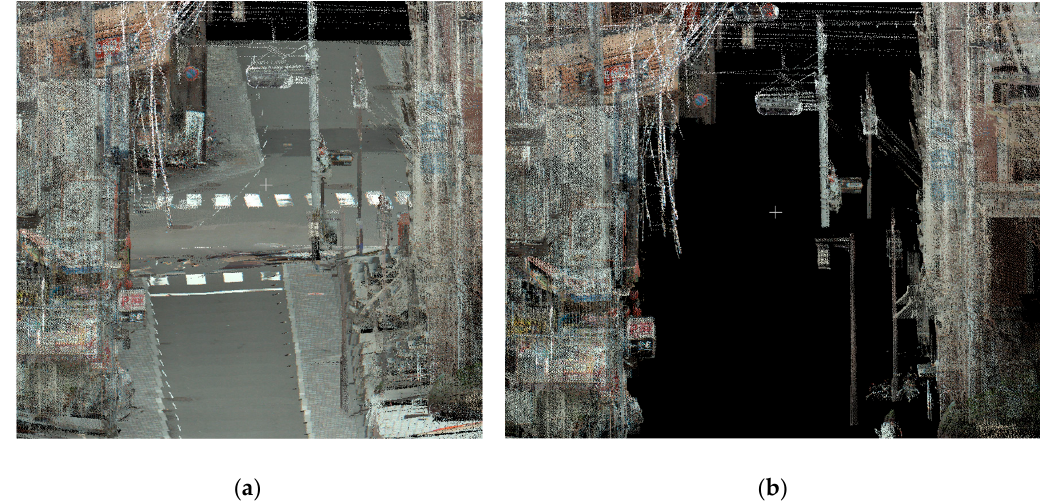
Figure 9. Laser-scanned point cloud of Sanjo Street: ( a ) Raw laser-scanned point cloud of Sanjo Street in Kyoto city, and ( b ) processed point cloud, in which the ground surface was removed to prepare the collision detection simulation.